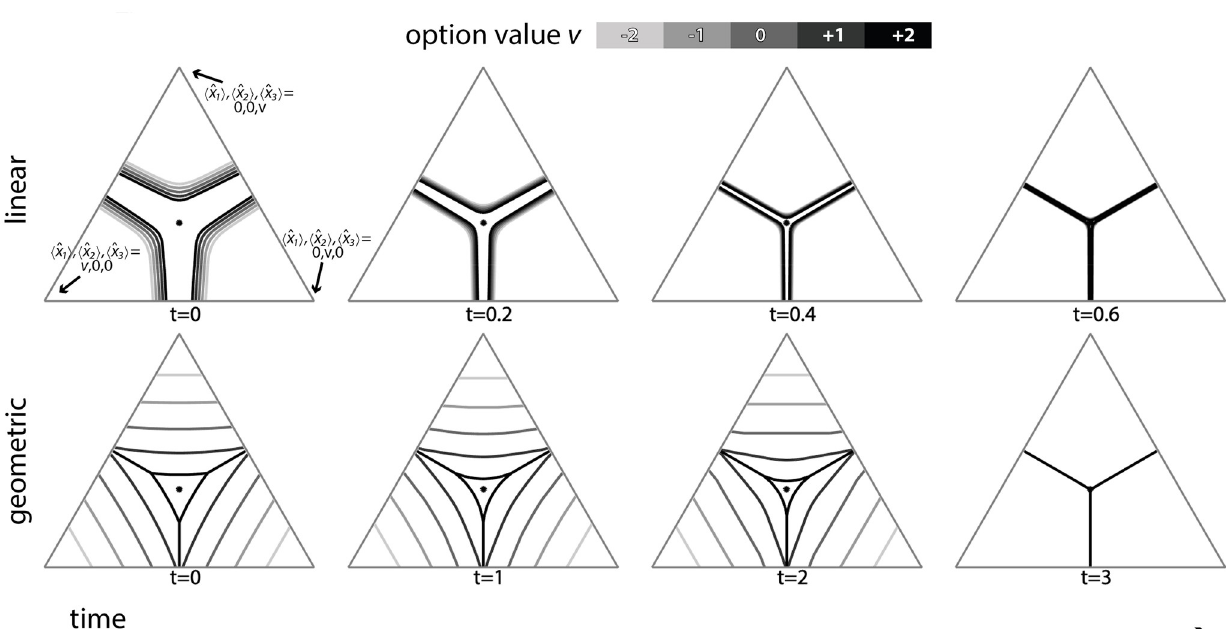
Fig 3. Optimal decision boundaries in the space of possible estimates of option values: Linear time costs lead to weakly magnitude-sensitive optimal policies (top row), while geometric discounting of reward leads to strongly magnitude-sensitive optimal policies (bottom row). In the linear time cost (Bayes Risk) case nonlinear subjective utility changes complex time and value-dependent decision boundaries in estimate space into a simple mostly magnitude-insensitive ‘best-vs-next’ strategy (top row; see [4], Fig 6C). For geometric discounting of rewards over time, optimal decision boundaries are strongly magnitude-sensitive and interpolate between simple ‘best-vs-average’ and ‘best-vs-next’ strategies (see [4], Fig 6). Triangles are low dimensional projections of the 3-dimensional evidence estimate space onto a plane moving along the equal value line, at value v [4]. Dynamic programming parameters were: prior mean � x ¼ 1 : 5 and variance s 2 ¼ 5 , waiting time t w = 1, temporal costs c = 0, γ = 0.2, and utility function parameters m = 4, s = 0.25 (for the p ; i p ; i linear time cost) and m = 4, s = 3.5 (for the geometric time cost). Time steps chosen to illustrate boundary